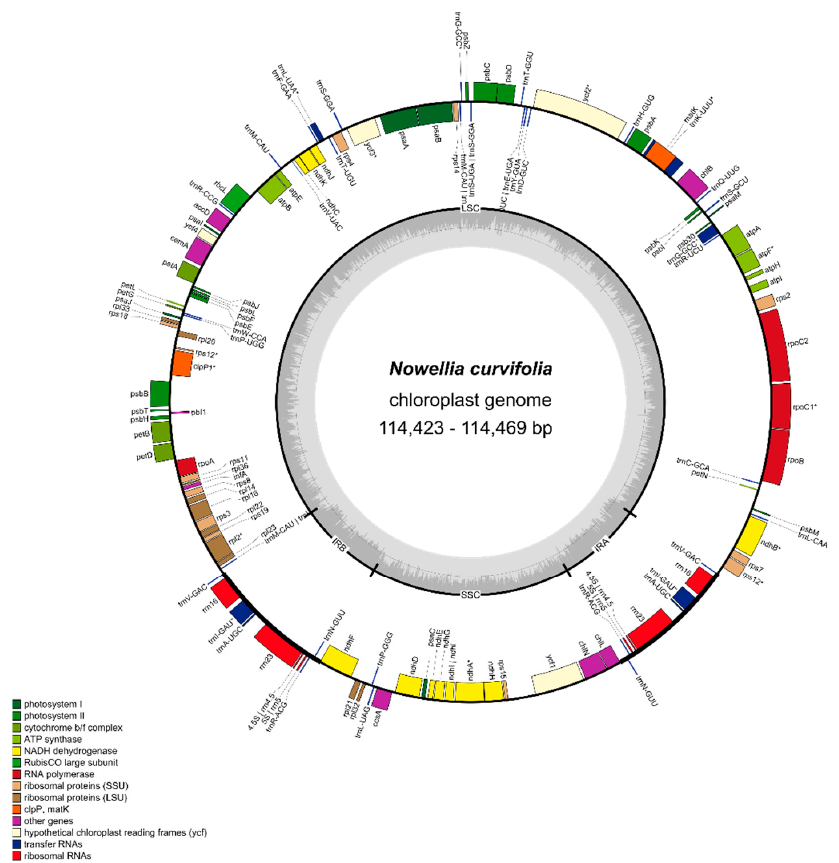
Figure 1. Gene map of the chloroplast genome of Nowellia curvifolia . Genes inside and outside the outer circle are transcribed in counterclockwise and clockwise directions, respectively. The genes are color-coded based on their function. The inner circle visualizes the G/C content. The reduction of plastome length is splitted among all four regions (Supplementary Figure S1): detected IRs were 8,086 bp (8,870 bp and 9,022 bp in Scapania , and Douinia , respectively), LSC is 79,341-79,293 bp (80,850 bp and 81,142 bp in Scapania and Douinia respectively) and SSC is 18,956 (19,436 bp and 19,611 bp in Scapania , and Douinia , respec- tively). Considering all known complete liverwort plastome sequences, Nowellia chloro- plast genome is the third smallest one, with Cololejeunea lanciloba second (108,674 bp) and mycoheterotrophic Aneura mirabilis with the smallest genome among liverworts (108,007 bp). The biggest difference among these three species is the length of SSC, which is 13,974 bp and 14,268 bp in A. mirabilis and C. lanciloba respectively, in the latter caused by the deletion of the ndh F- ccs A region. The differences in LSC length are much smaller (77,553 bp in A. mirabilis and 78,204 bp in C. lanciloba ), but the IRs of N. curvifolia plastome are the shortest among known liverwort chloroplast sequences, passing C. lanciloba by 15 bp. The reduction of plastome length in leafy liverworts is often caused by deletions around the ycf 2 gene [10]. The region between psb A and psb D genes contains, besides the previously mentioned ycf 2 gene, four tRNAs: trn H-GUG, trn D-GUC, trn Y-GUA and trn E- UCC, and in the case of Nowellia and Scapania this region is 1797 bp shorter in the former. Keeping in mind that the total difference in LSC length between these species is 1509 bp, the role of this region in plastome length reduction is leading. As in the closest known relatives with a plastome sequence mentioned above, the plastome of N. curvifolia consists of 121 unique genes, including 81 protein-coding genes, 6 genes of unknown function ( ycf genes), 4 ribosomal RNAs and 30 transfer RNAs (Sup- plementary Table S2). The gene order and content seem to be stable in the most of leafy